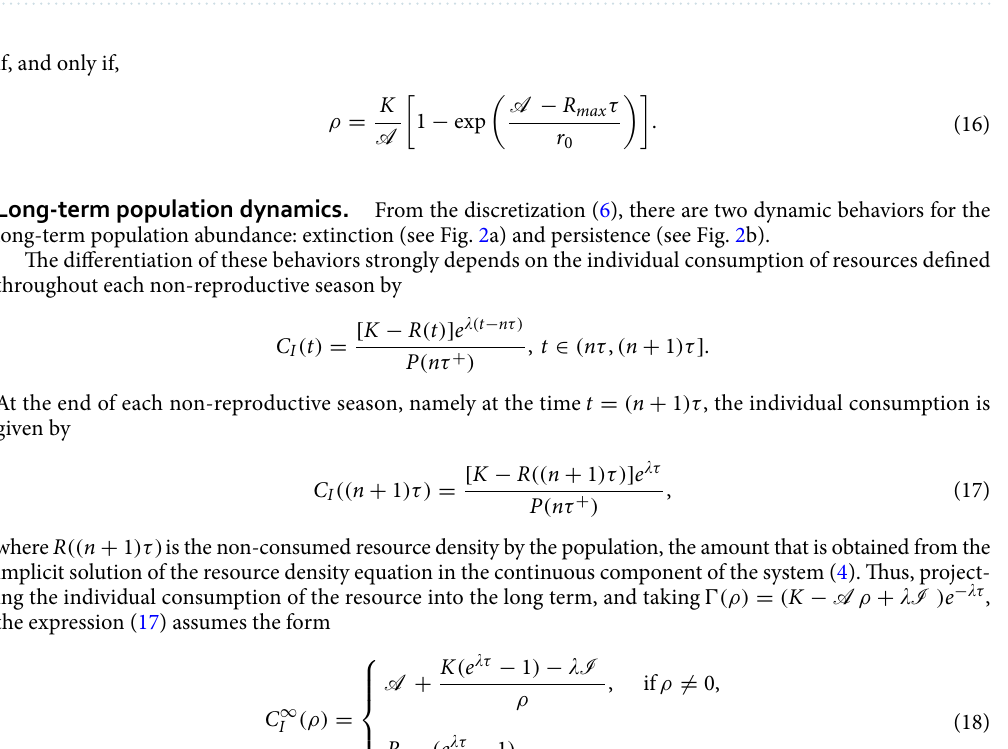
Figure 2. Long-term behavior of solutions of the model (4). Peak values correspond to the solution of the discrete model (6) in its population component. ( a ) Extinction behavior, considering α ∈ { 0.1, 0.8 } as energy allocation strategy toward reproductive and ( b ) persistence behavior considering α ∈ { 0.35, 0.55 } . We consider the following parameter set η = ( 2, 0.5, 2, 0.25, 500, 2, 1, 0.5, 0.5, 0.86, α , 0.1 ) where the constant of fertility costs is described by κ = ( 1 + γ) − 1